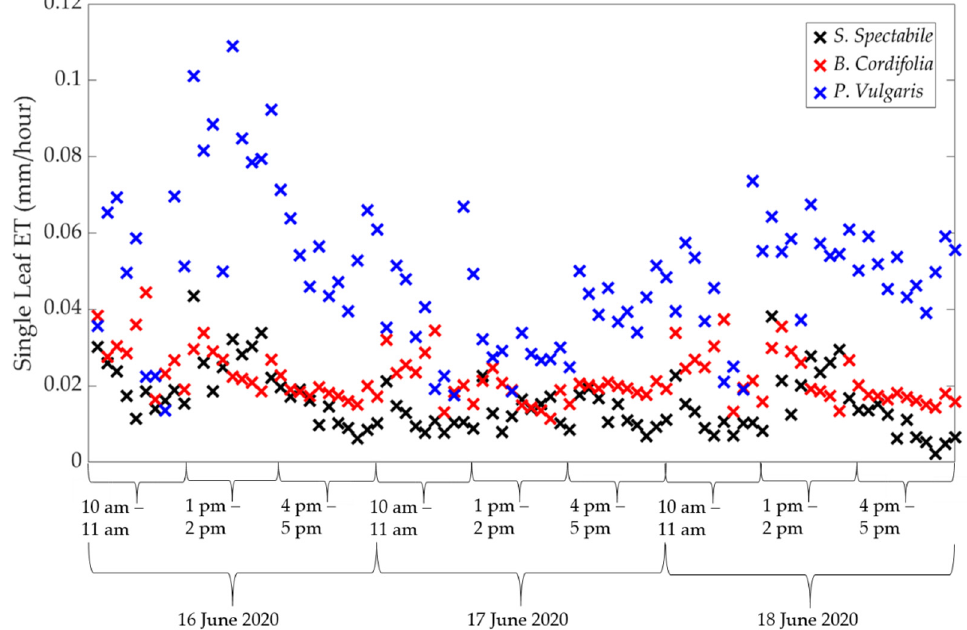
Figure 5. Single leaf ET rates found via porometry for S. spectabile , B. cordfolia and P. vulgaris species. Data shown are between 16–18 June in each measurement session.